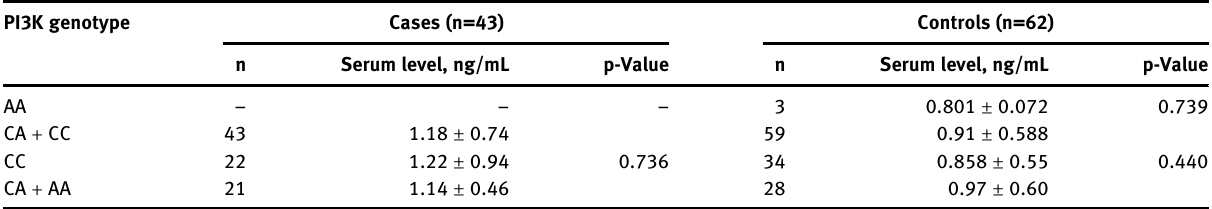
Table  : PIK  CA :rs  (C>A)polymorphism allele distribution and serum PI  K levels (ng/mL) in BC patients and healthy